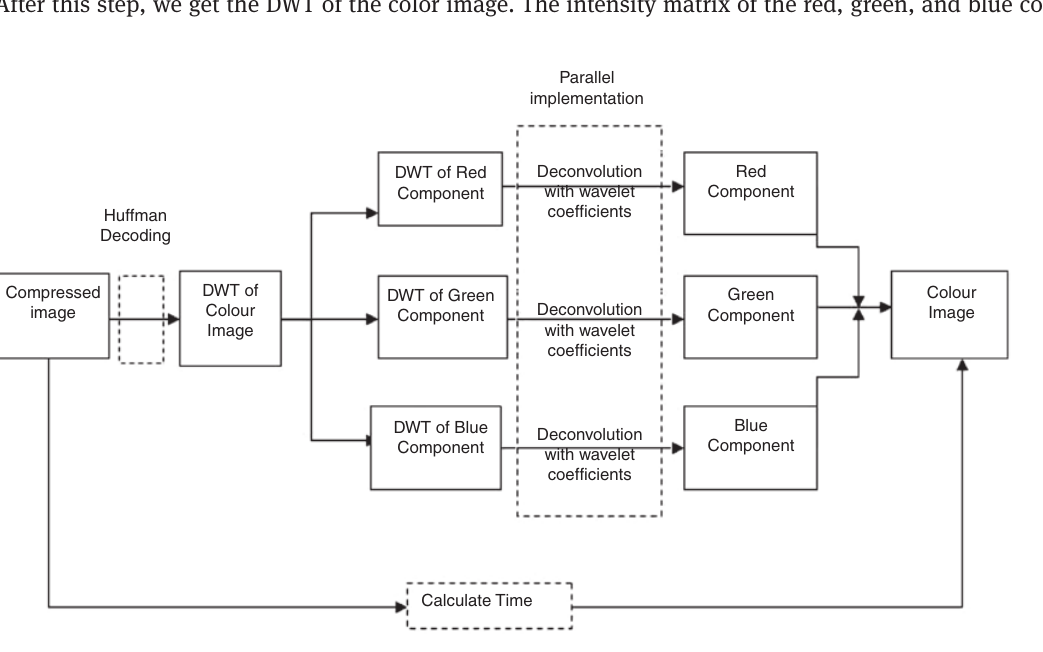
Figure 2: Block Diagram for Color Image Decompression using Parallel Image Decompression Algorithm.